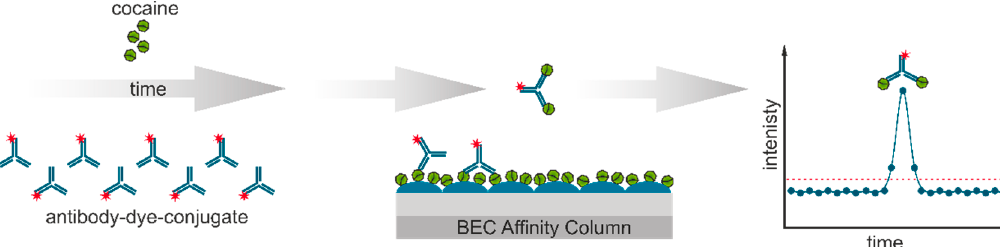
Figure 1. Assay principle: Fluorescently labeled anti-cocaine antibody is mixed with the sample and injected onto an affinity column coated with a conjugate based on the cocaine derivative benzoylecgonine (BEC). Unbound antibodies are immediately detected by an increased fluorescence signal.